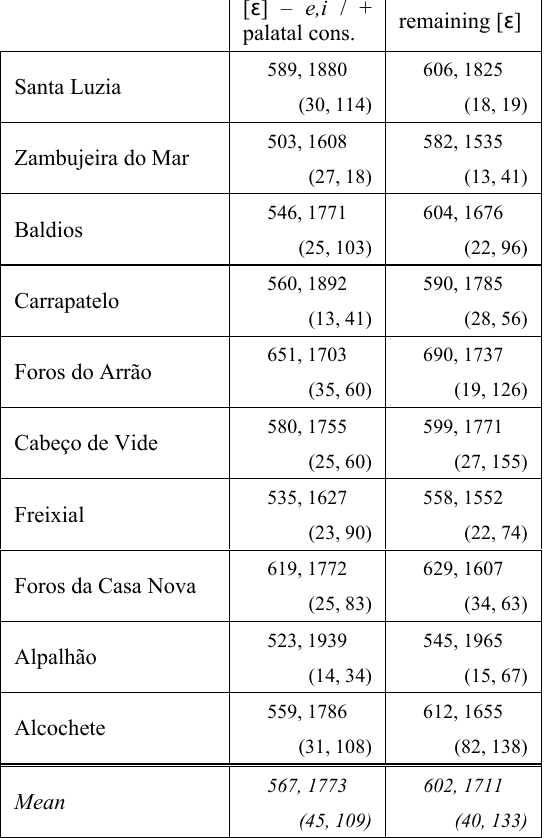
Table V. Mean values: F1, F2 (standard deviations in parentheses). [ ɛ ] – e,i / + palatal